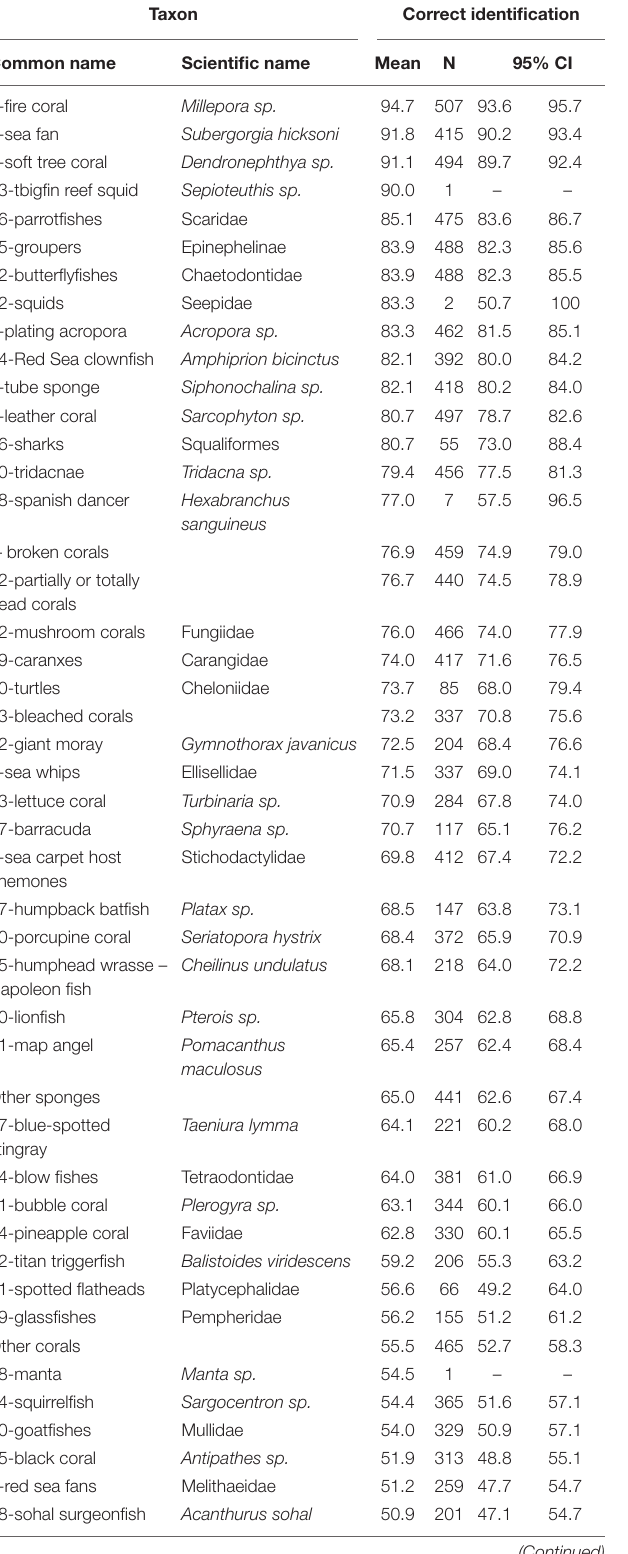
TABLE 4 | Results of the correct identification analysis with mean score of correct identification performed by volunteers for each taxon.